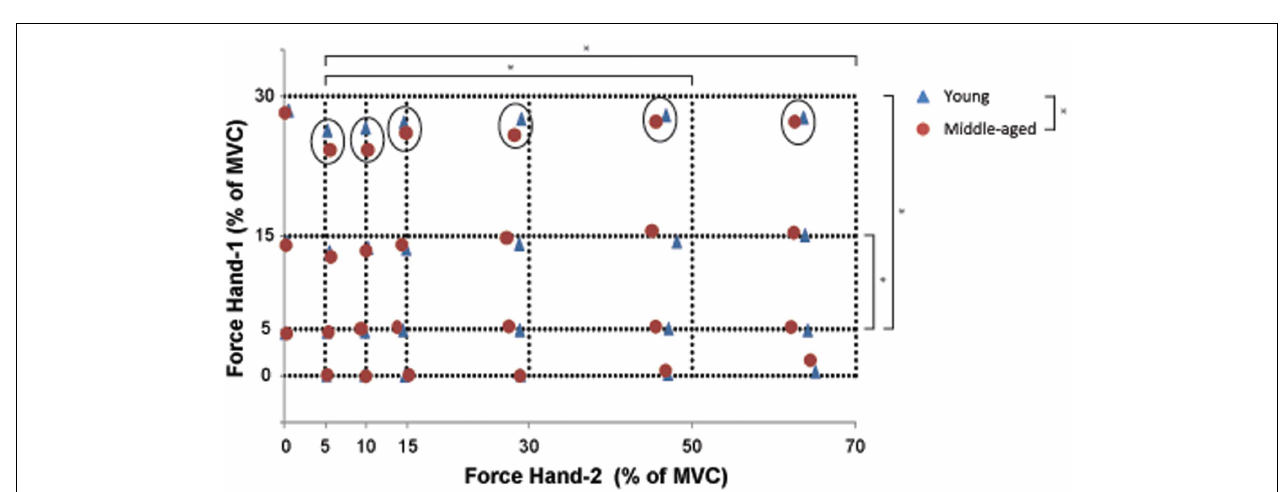
difference across bilateral force combinations are indicated by an asterisk (unilateral contractions were not included in the statistical analysis; main effect of Hand-1 and -2).The circles point to an Age-group effect on the amplitude of the force difference at high force levels in Hand-1. Overall, the force difference was larger for the middle-aged than for the young participants.